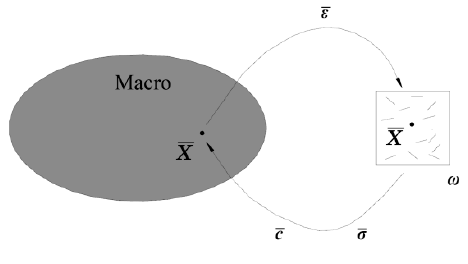
Figure 9. Multi-scale method.